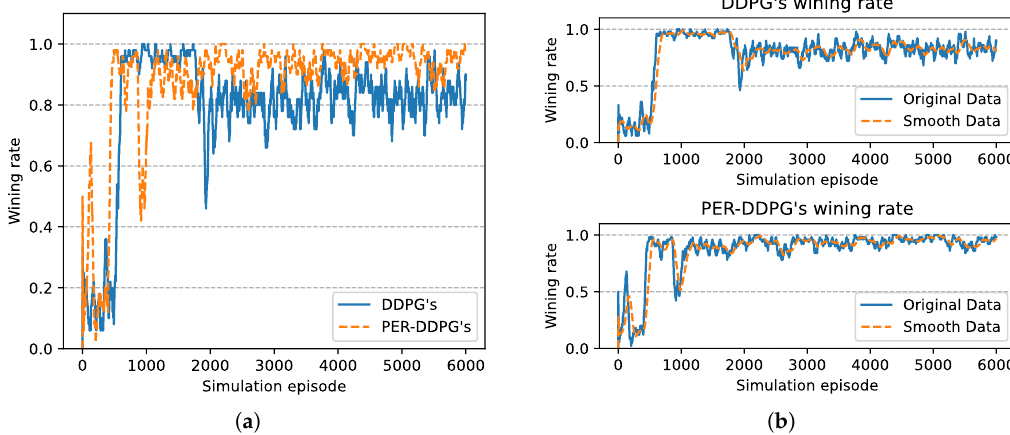
Figure 15. The winning rate of algorithms based on UER-DDPG and PER-DDPG over simulation episode. Winning rate means a rate of finishing mission successfully. ( a ) The comparison of winning rate based on UER-DDPG and PER-DDPG. ( b ) The figure in 1st row is the winning rate of algorithm based on UER-DDPG, and the figure in 2nd row is the winning rate of algorithm based on